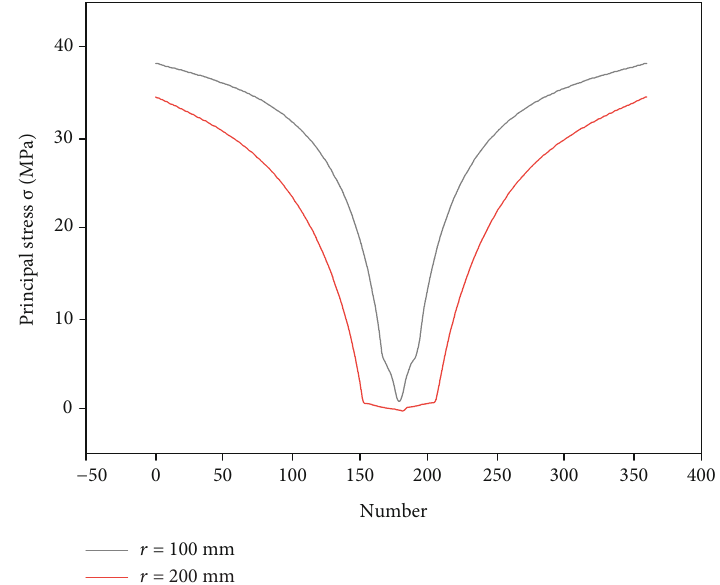
Figure 6: 100 mm and 200mm distribution of principal stress in boreholes.